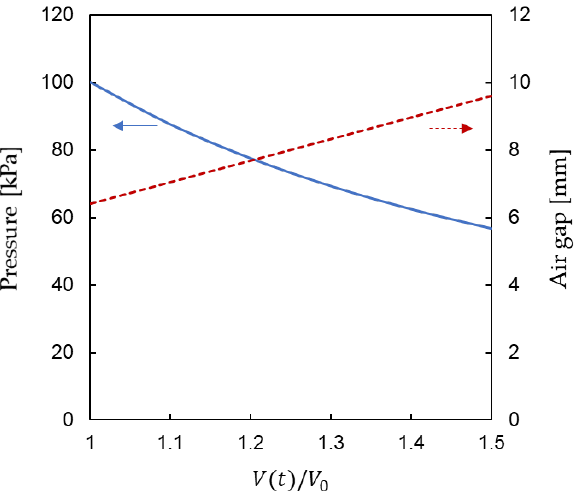
Figure 8. The change of the pressure and the gap thickness according to the volume change of the gap between the upper and the lower bodies of WavoWater.